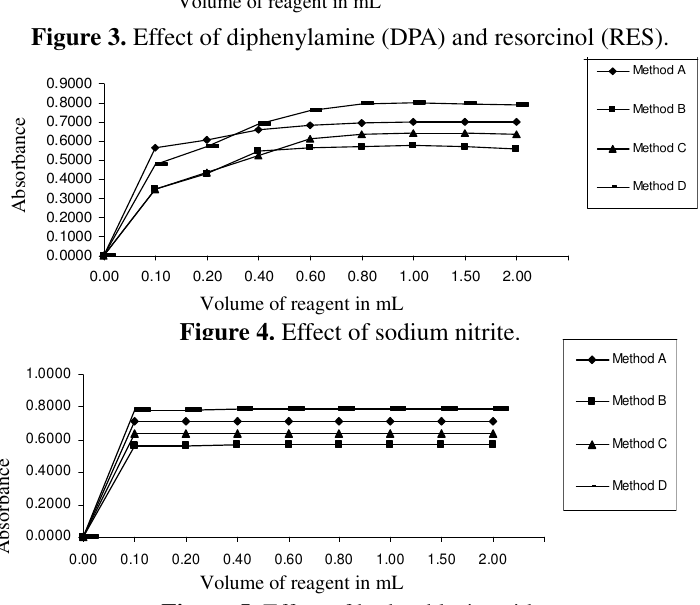
Figure 5. Effect of hydrochloric